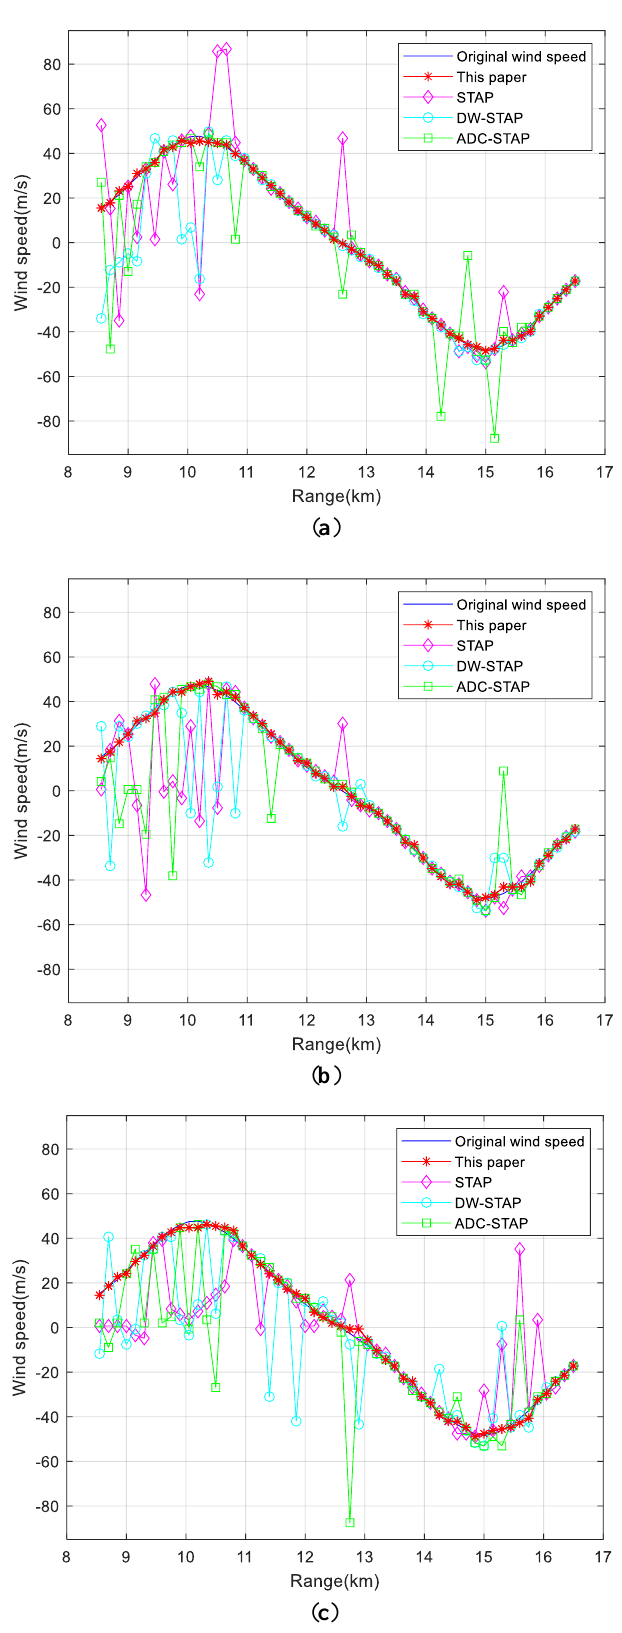
Figure 8. Comparison of the wind speed estimation results under different PRF conditions. ( a ) 5000 Hz ( b ) 6000 Hz ( c ) 7000 Hz